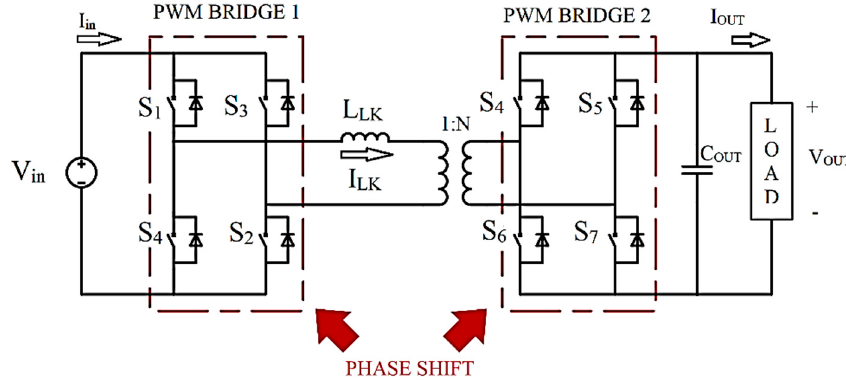
Figure 1. Topology of a dual active bridge (DAB) converter.